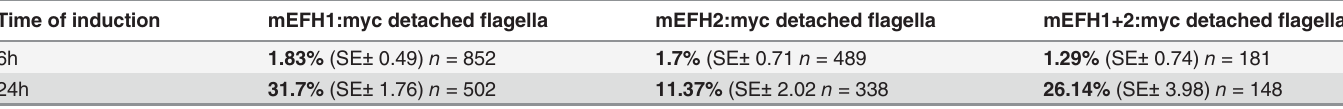
Quanti fi cation of the percentage of cells exhibiting detached fl agella phenotypes after six and 24 h expression of mEFH1:myc, mEFH2:myc and mEFH1+2:myc tagged proteins in procyclic T . brucei cells. Expression of all EF-hand mutations induced detached fl agella